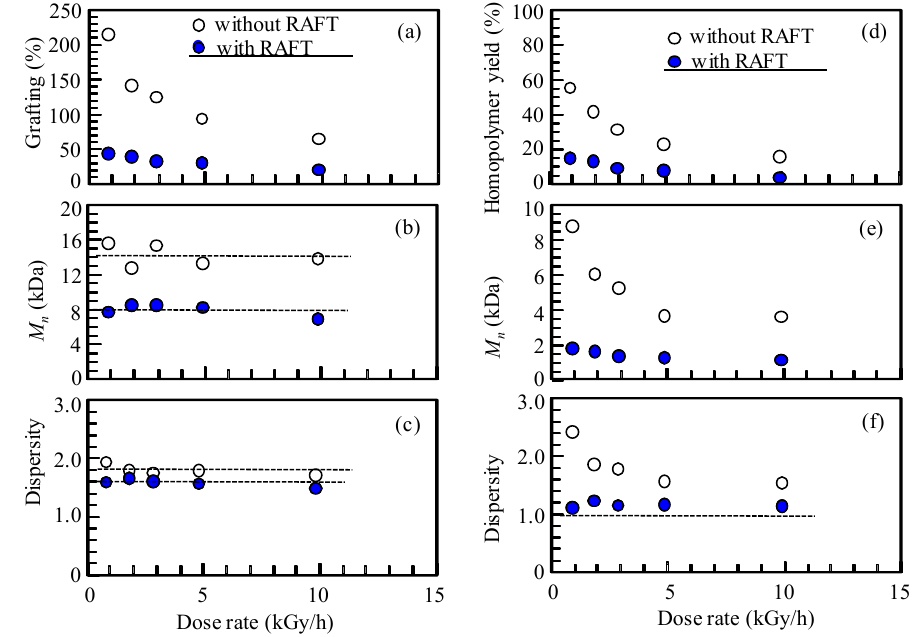
Figure 5. ( a ) Degree of grafting, ( b ) M n , ( c ) dispersity of the extracted poly(CMS) in the ETFE films, and ( d ) homopolymer yield, ( e ) M n , ( f ) dispersity of the homopolymer in the monomer solution as a function of the irradiation dose rate. Total irradiation dose, 50 kGy; [RAFT]/[CMS], 0.014.